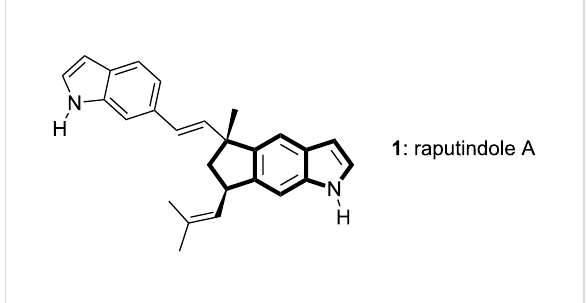
Figure 1: Bisindole alkaloid raputindole A ( 1 ) from the Amazonian tree Raputia simulans .